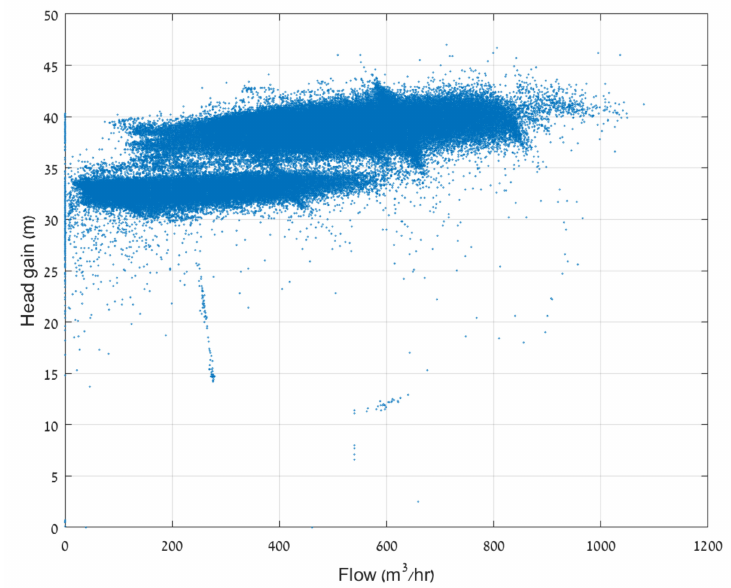
Figure 6. Pumping station Flow-Head Gain